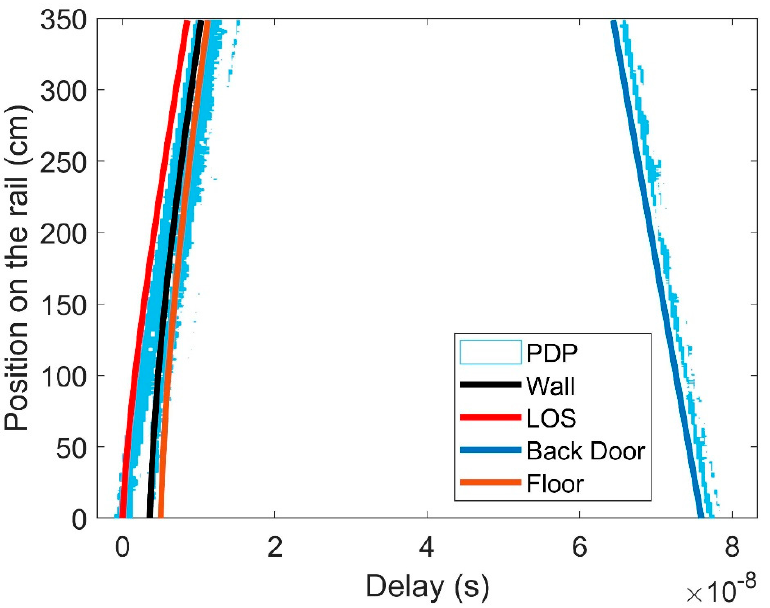
Figure 7. Mapping the measured power delay profile (PDP) and ray-tracing estimations for the corridor channel received by antenna “3” in line of sight (LOS) conditions at the 60 GHz band.